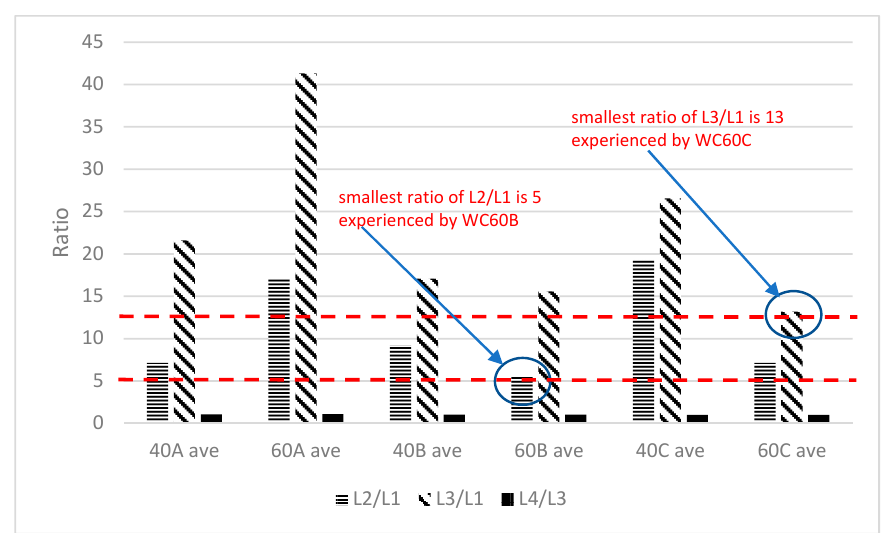
Figure 16. Average CHV according to L1, L2, L3, and L4.